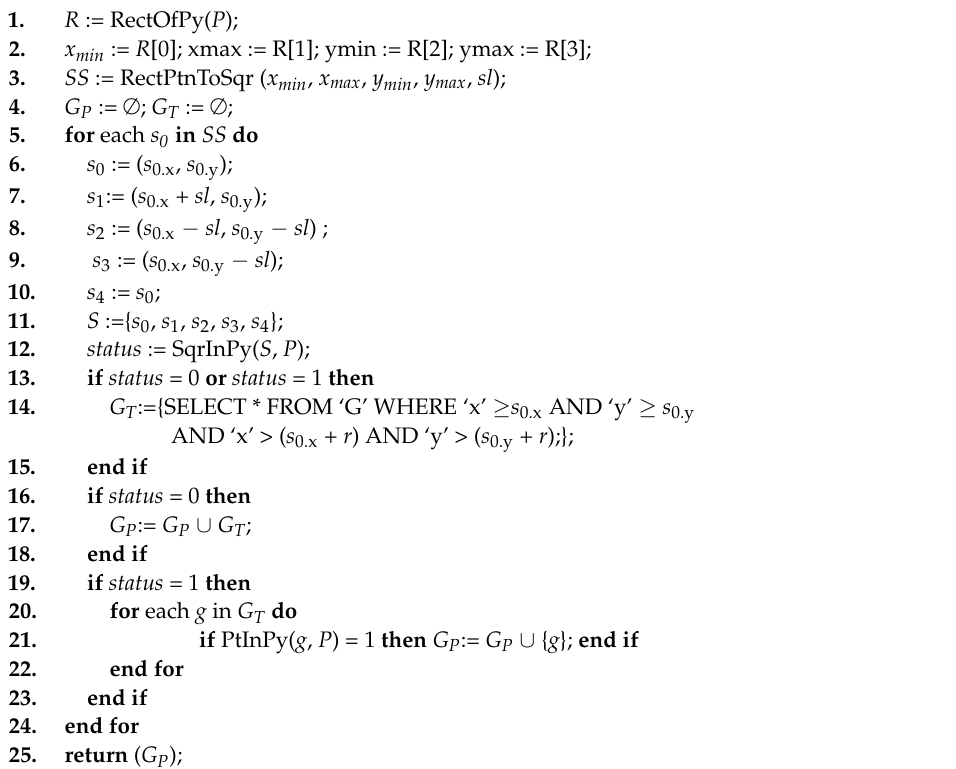
Algorithm 6. CoordRecognit (polygon P , point set G , side length sl